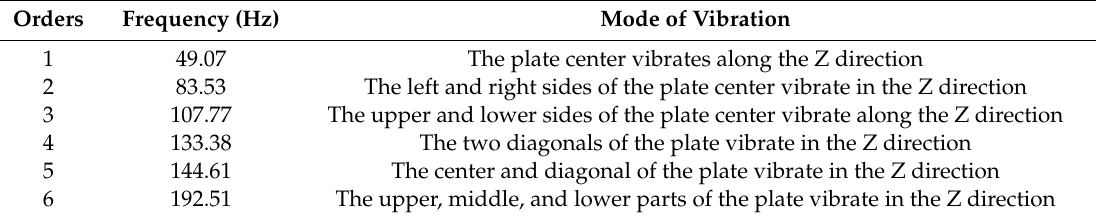
Figure 15. Six-order mode shape of variable-angle laminates of [0 ± < 20 (0.6) 60 >] 2s . Table 4. Modal analysis of variable-angle laminates of [0 ± < 20 (0.6) 60 > ] 2s